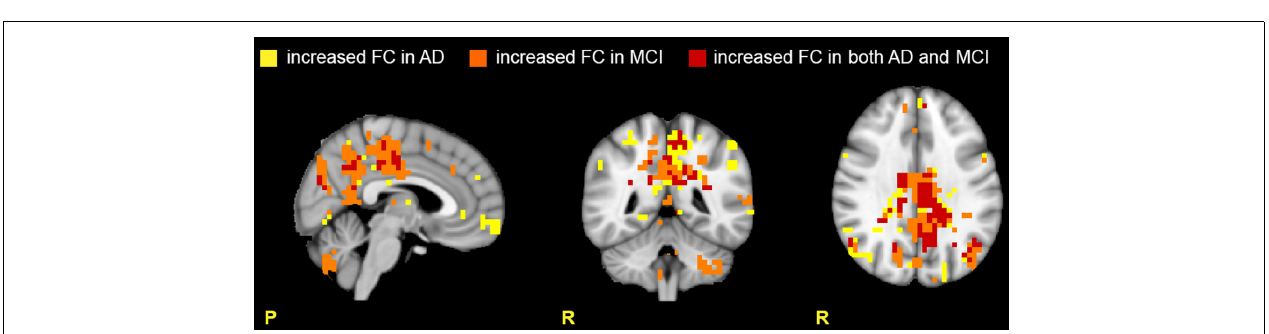
mainly located in the prefrontal (PreF) and precentral (PreC) areas. Moreover ADs present a larger number of areas with reduced FC than MCI suggesting a more extended functional corruption in AD than MCI.